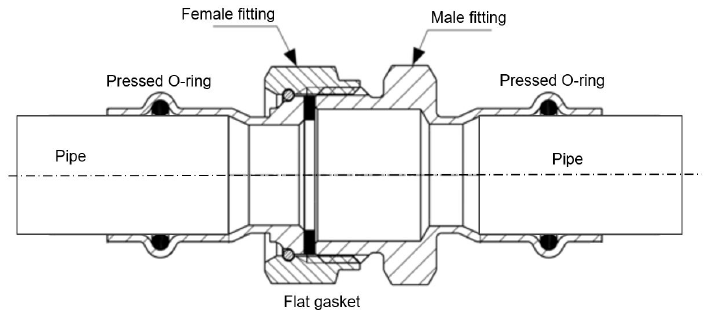
Figure 11. Lateral section of the pressed joints and threaded joints, pressfitting INOXPRES.